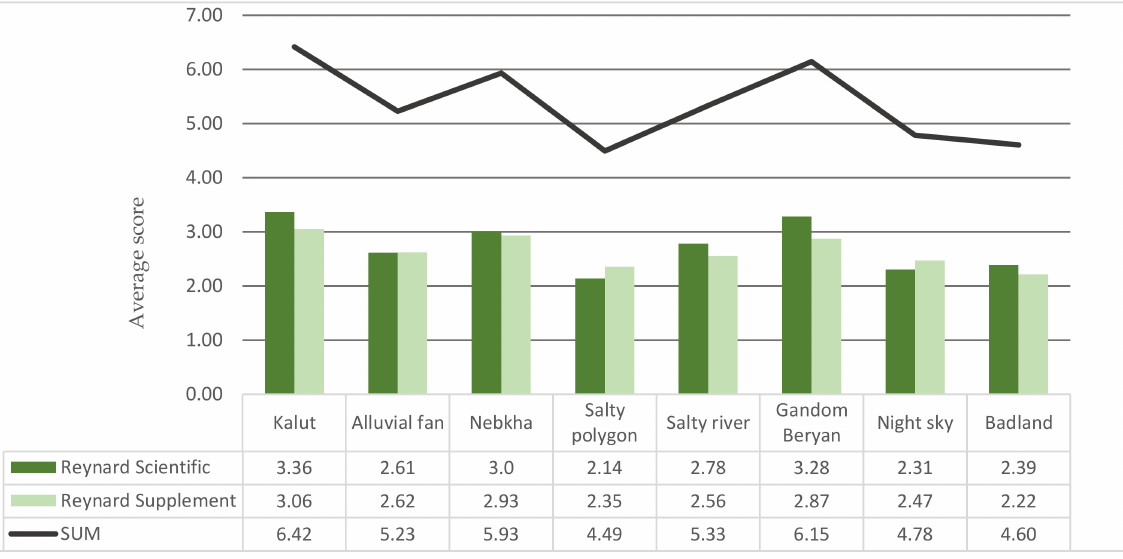
Figure 4. Final results of the evaluation of the studied sites using the Reynard